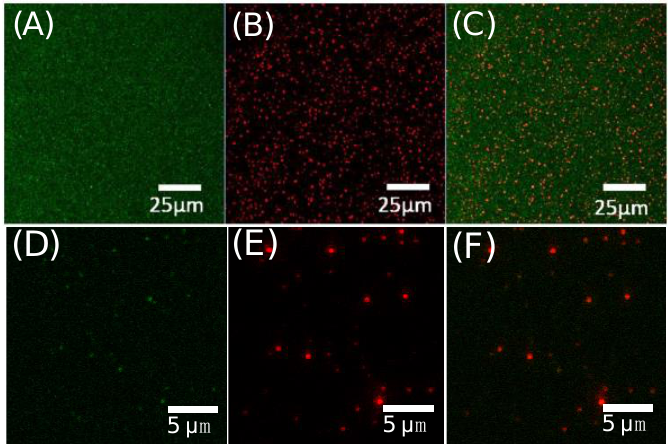
Figure 2. Confocal microscope images of FND–AB. Fluorescein (FITC) labelled antibodies ( A ), FNDs ( B ), and merged images ( C ). ( D – F ) show FITC, FND and merged images in